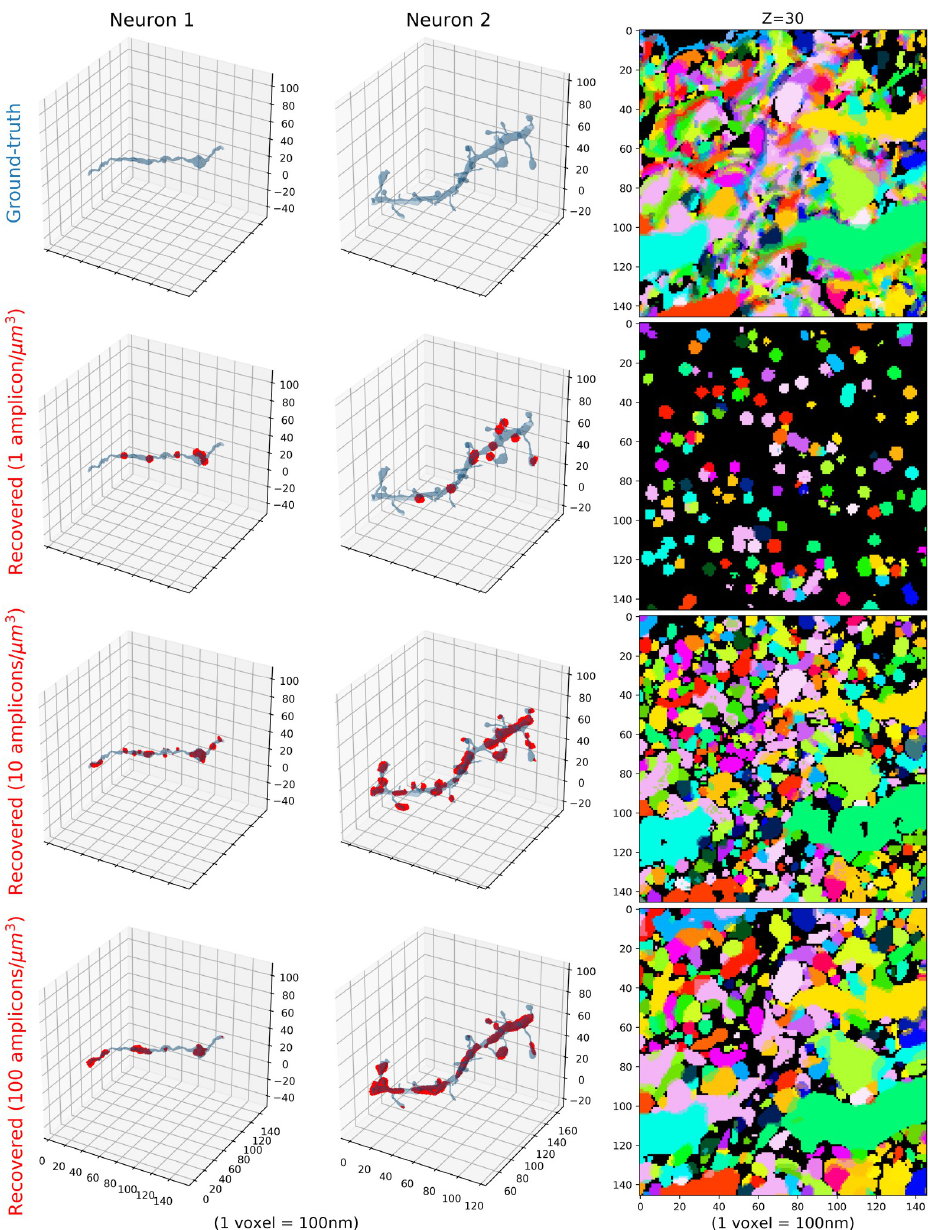
Fig 8. Estimated amplicon locations (binarized evidence tensor) from high-resolution, dense-expression simulations, with 1, 10 and 100 amplicons per cubic micron. Given an imagestack from a STIBE, how well can we estimate the amplicon regions and can we roughly recover the morphology of individual neurons based on these regions? The first column visualizes one cell, the second visualizes another, both shown in blue shaded regions. The first row indicates ground-truth morphology of the cells. The second row shows our ability to locate the amplicon regions inside the cells using a high-resolution STIBE with λ = 1 amplicon/ μ m 3 ; identified locations, which are estimated using the binarized evidence tensor with threshold 0.7 (see S1 Fig for details on the choice of this threshold), are shown in red in the first two columns, and via unique colors in the third column. Note that these regions are often larger than the actual size of the amplicons because of point-spread effects during imaging. The final two rows visualize the same information for a STIBE with λ = 10 amplicons/ μ m 3 and λ = 100 amplicons/ μ m 3 . Right column : On top, we visualize many cells in a single slice of tissue, each indicated with a unique color. The following rows show the recovered neuronal shapes based on the binarized evidence vector. Colors match the right top panel. A video showing multiple z-slices corresponding to the right panel can be found at this